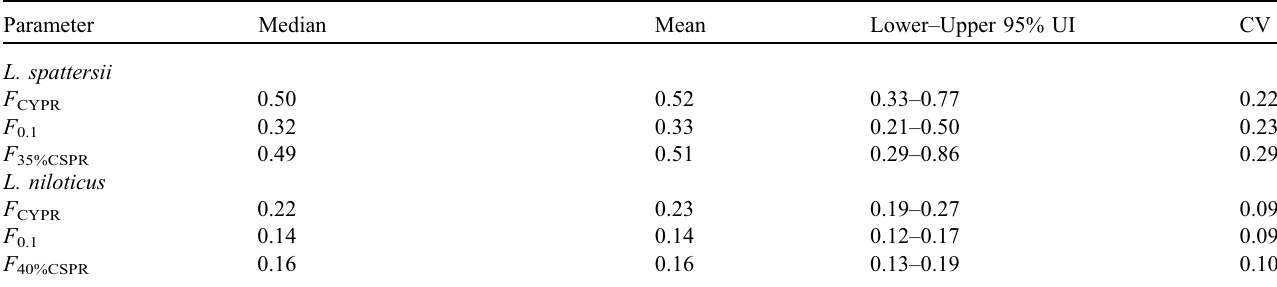
Table 3. Summary statistics of candidate fi shing mortality targets for L. stappersii in Lake Tanganyika and L. niloticus in Lake Victoria